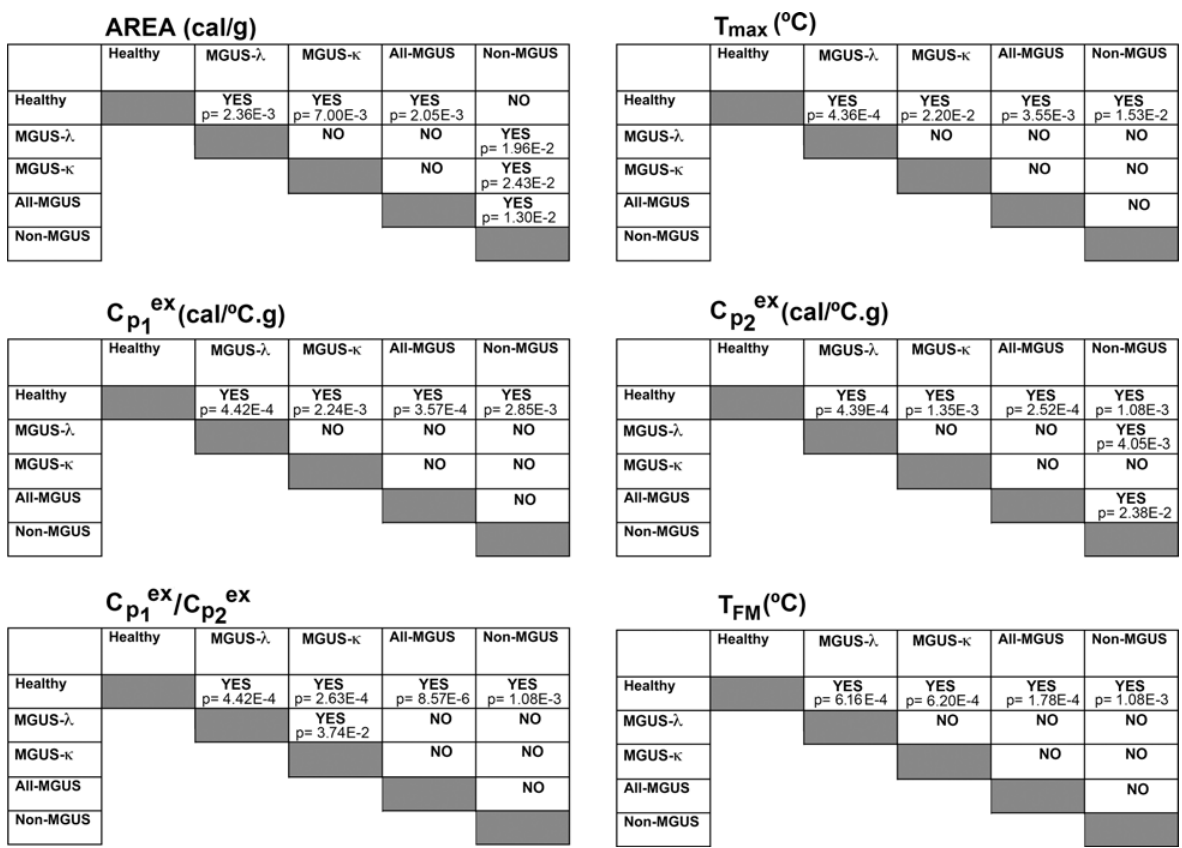
Fig 6. Differences in thermogram feature parameters across the serum sample groups. The thermogram feature parameters are identified at the top of each panel. The analysis of the data by a non-parametric Kruskal-Wallis test revealed significant differences in the six thermogram parameters displayed in the figure (Area, p = 9.82E-3; T max , p = 8.73E-3; Cp1 ex , p = 5.59E-3; Cp2 ex , p = 4.26E-4; Cp1 ex / Cp2 ex , p = 5.92E-4; T FM , p = 2.16E-3), indicating they can be used to distinguish the different serum groups, and also validated the utilization of post-hoc pairwise comparisons. Differences between the serum sample groups were examined for every thermogram parameter by the unpaired Mann-Whitney U test. The figure panels indicate “ yes ” or “ no ” to specify whether statistically significant differences occurred (the actual p values are shown in the panels).